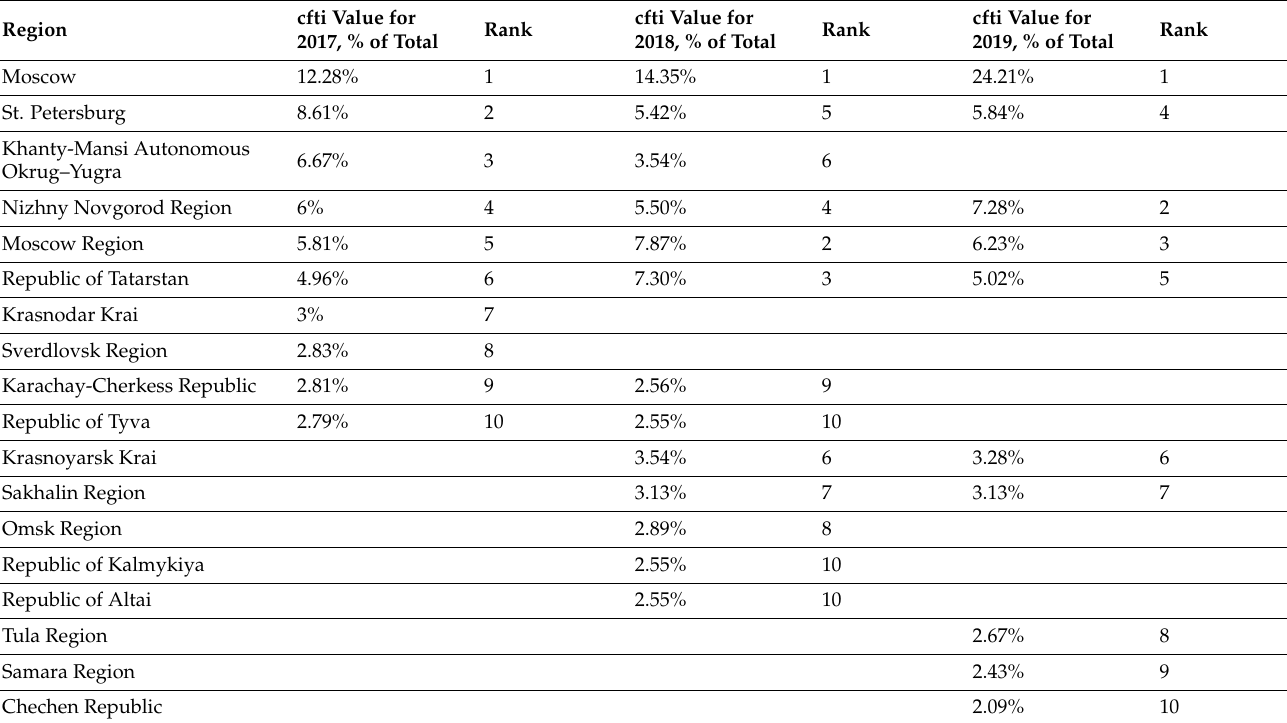
Table 10. Top 10 regions with the highest cfti indicator for 2017–2019.